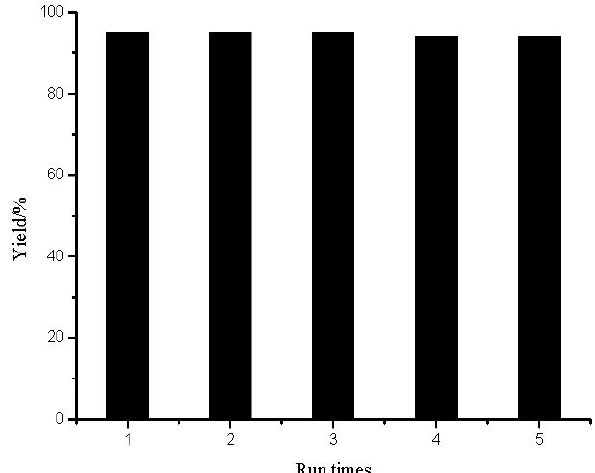
Figure 1. The reuse of the novel ionic